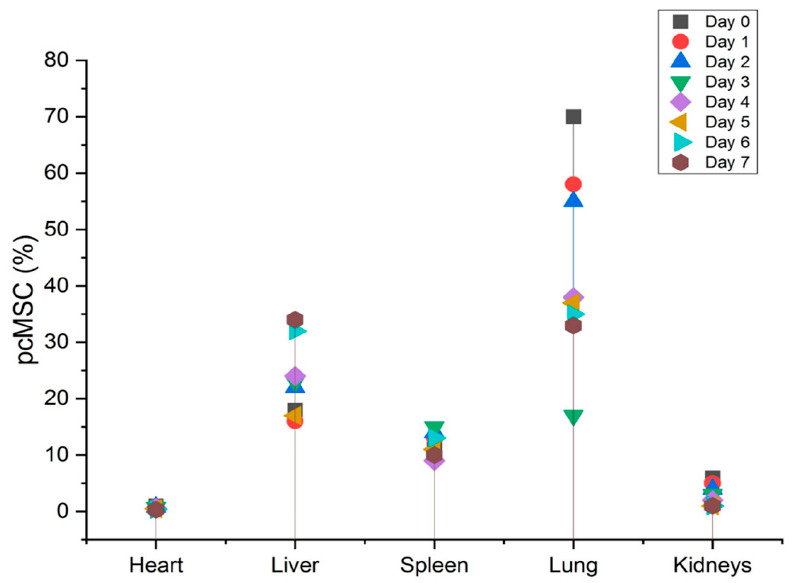
Figure 3. Location of FND-labeled pcMSCs in apparently healthy mice.